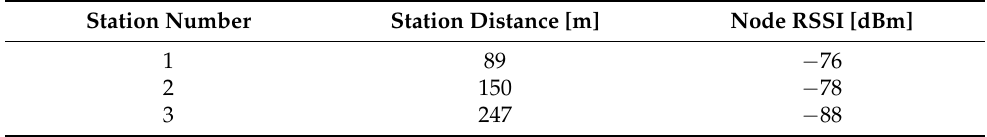
Table 7. Communication test results-Countryside